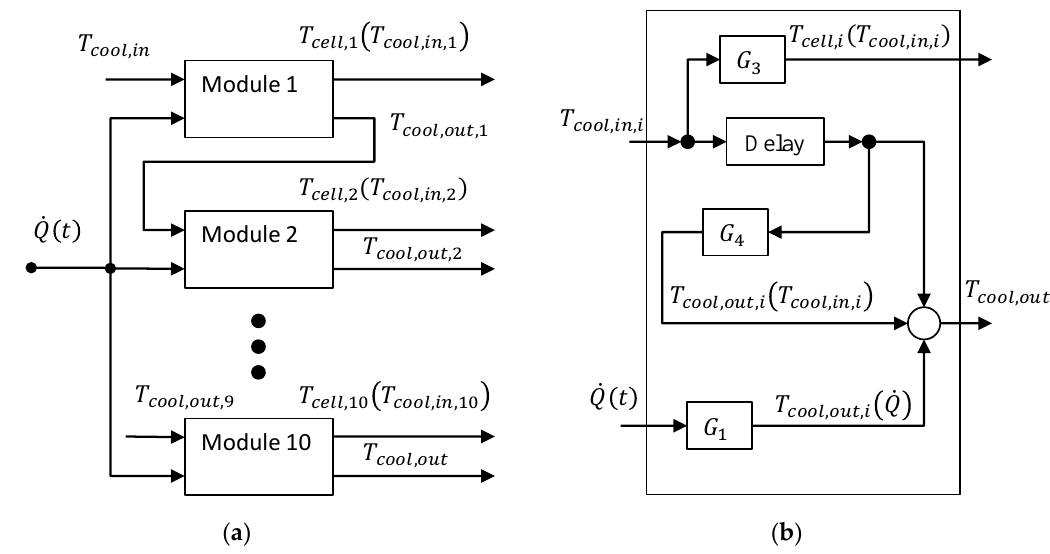
Figure 6. ( a ) Overview of the serial coolant flow connection of the battery modules. Inputs are heat production and coolant inlet temperature. Outputs are coolant outlet temperature and cell temperature due to the coolant inlet temperature. ( b ) Overview of the calculation procedure for one module. Coolant outlet temperature is defined by the coolant inlet temperature and 𝐺 4 in conjunction with heat production and 𝐺 1 . The cell temperature as a function of coolant inlet is defined by 𝐺 3 .